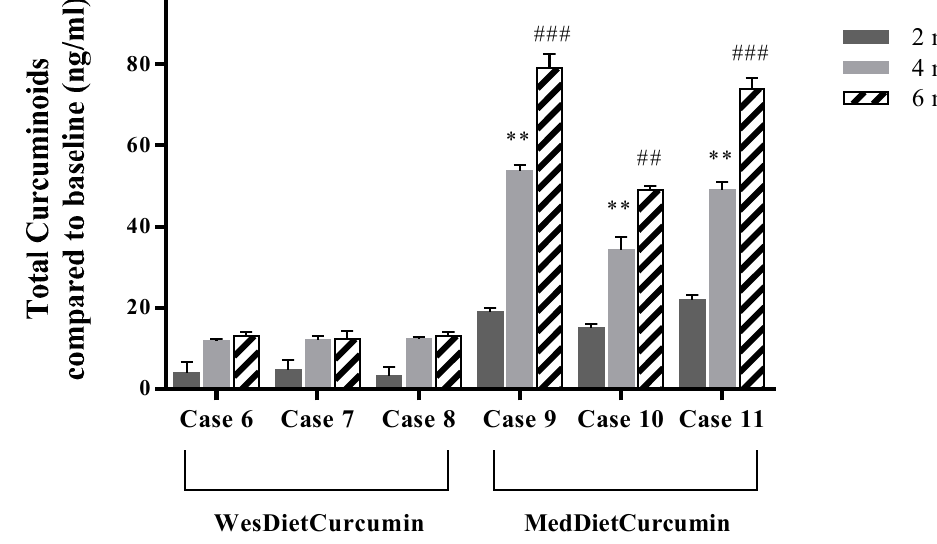
Figure 5. Plasma levels of curcuminoids. HPLC analysis of enzymatically hydrolyzed plasma samples. For each sample, three different experiments were conducted and the results expressed as the mean of the values obtained (mean ± SD). Statistically significant variations: ** p < 0.01 4 months diet versus 2 months diet; ## p < 0.01 6 months diet versus 2 months diet; ### p < 0.001 6 months diet versus 2 months diet.